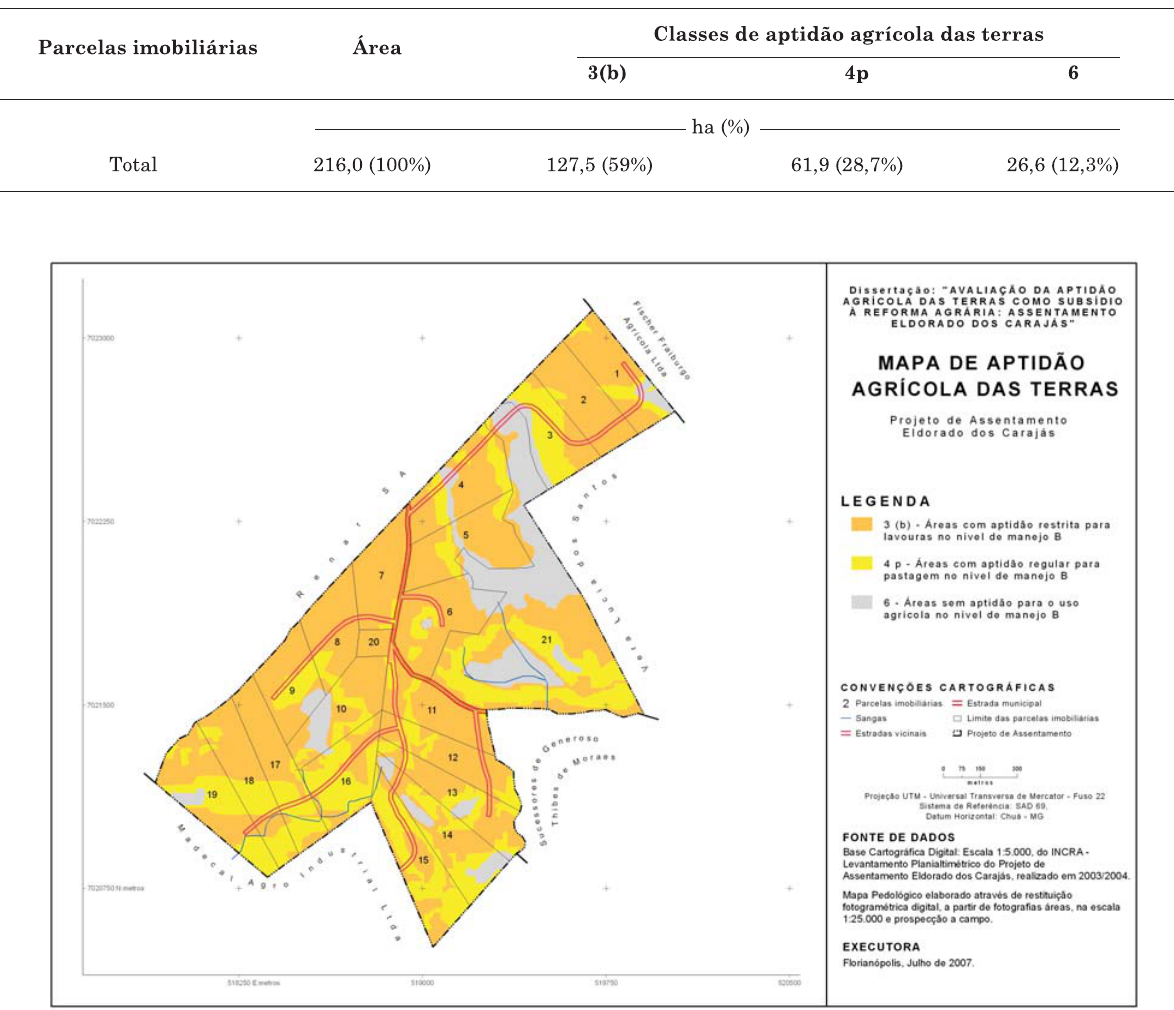
Figura 4. Mapa de aptidão agrícola das terras do